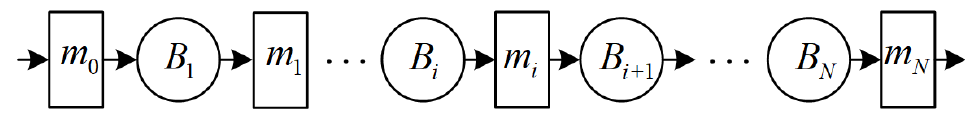
Figure 5. General system configuration structure.